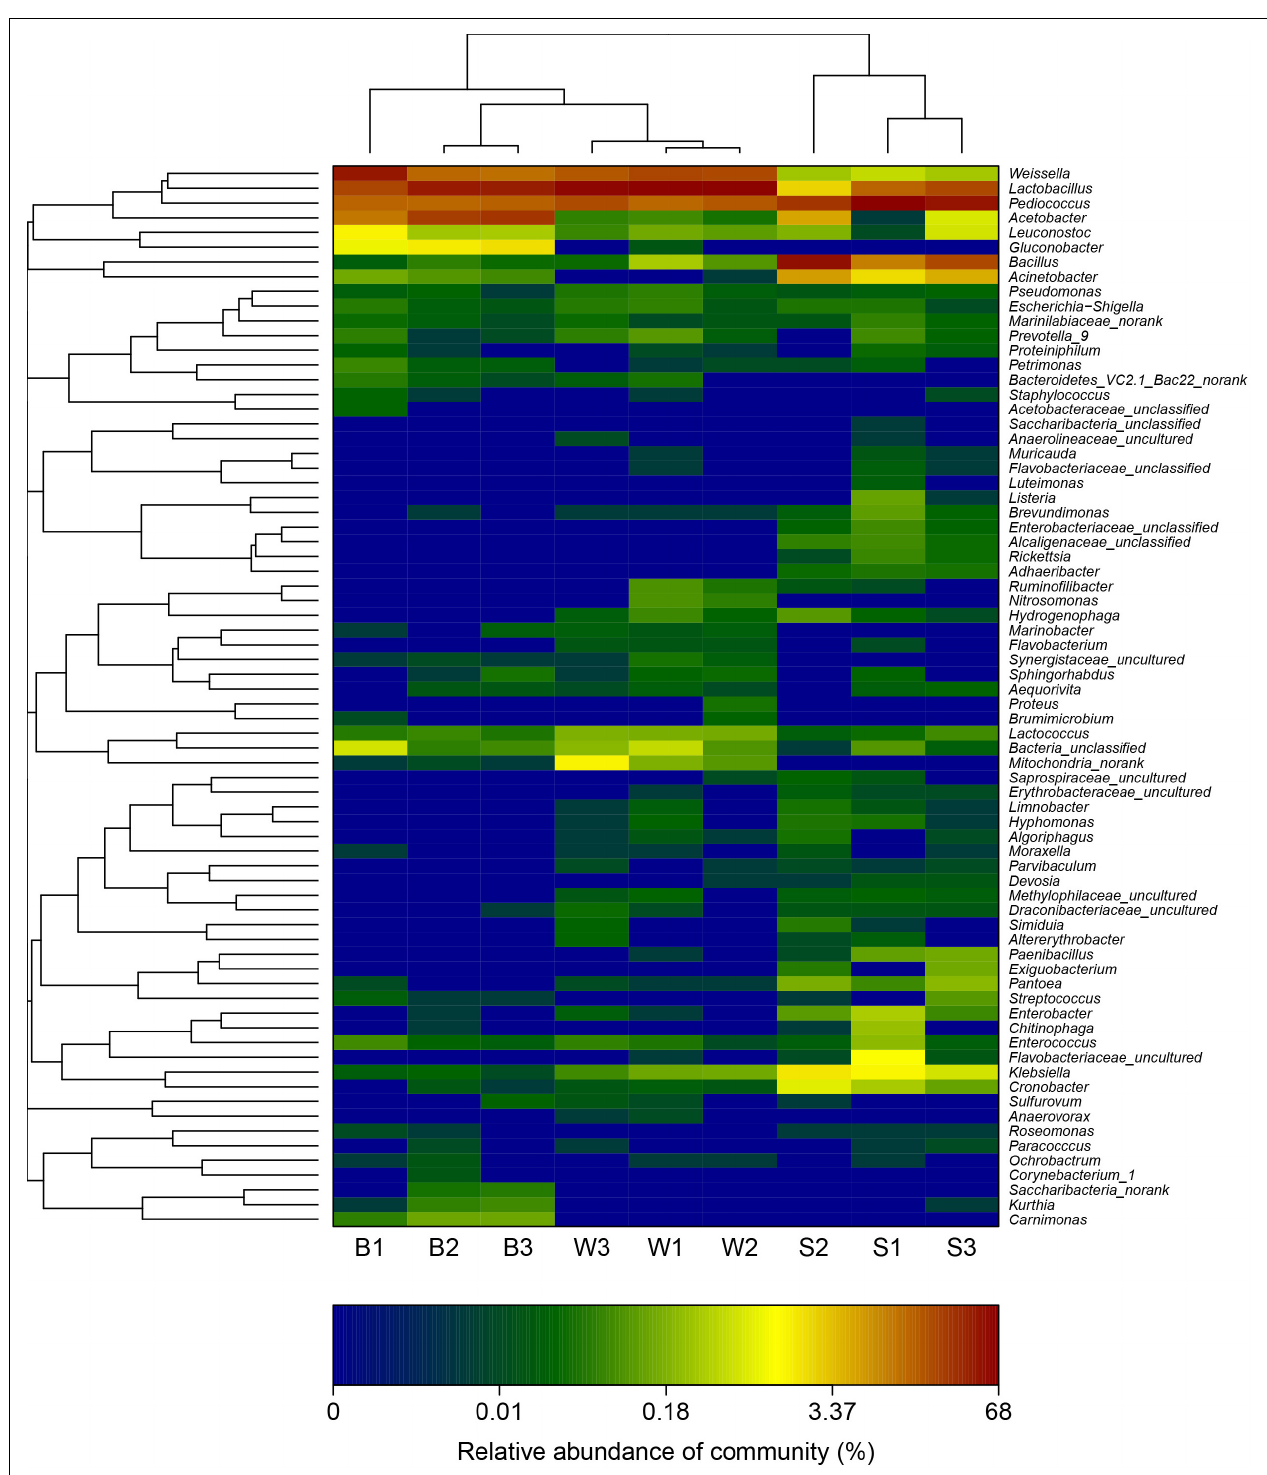
FIGURE 5 | Double hierarchical dendrogram showing the bacterial distribution among nine samples. The bacterial phylogenetic tree was calculated using the approximately-maximum-likelihood method, and the relationship among samples was determined by the Bray distance and the complete clustering method. The heatmap plot depicts the relative percentage of each bacterial genus (variables clustering on the y-axis) within each sample (x-axis clustering). The relative values for bacterial genus are depicted by color intensity with the legend indicated at the bottom of the figure. Clusters based on the distance of the nine samples along the X-axis and the bacterial genera along the Y-axis are indicated in the upper and left of the figure, respectively.